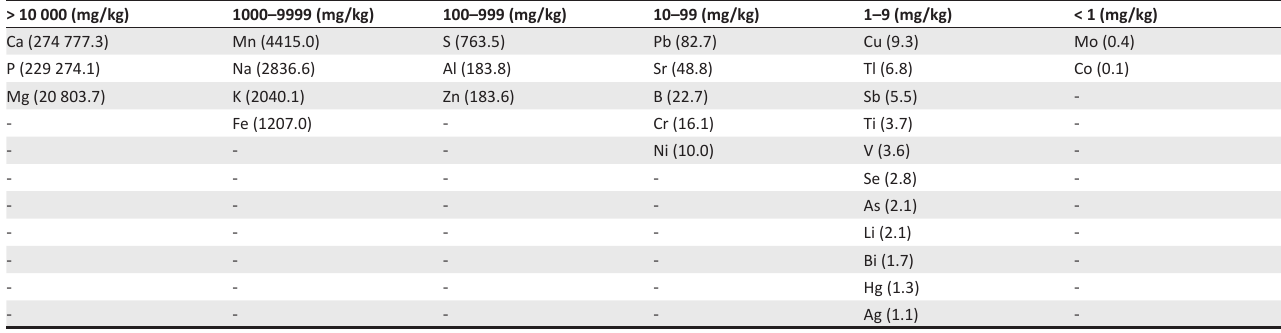
TABLE 1: Chemical analysis of the